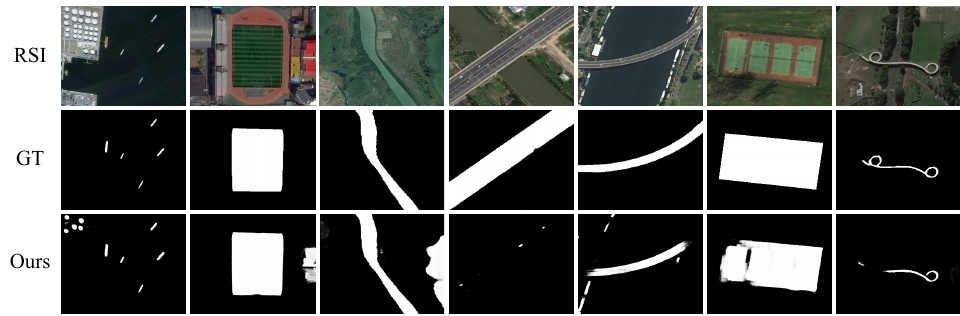
Figure 10. Some failure cases in